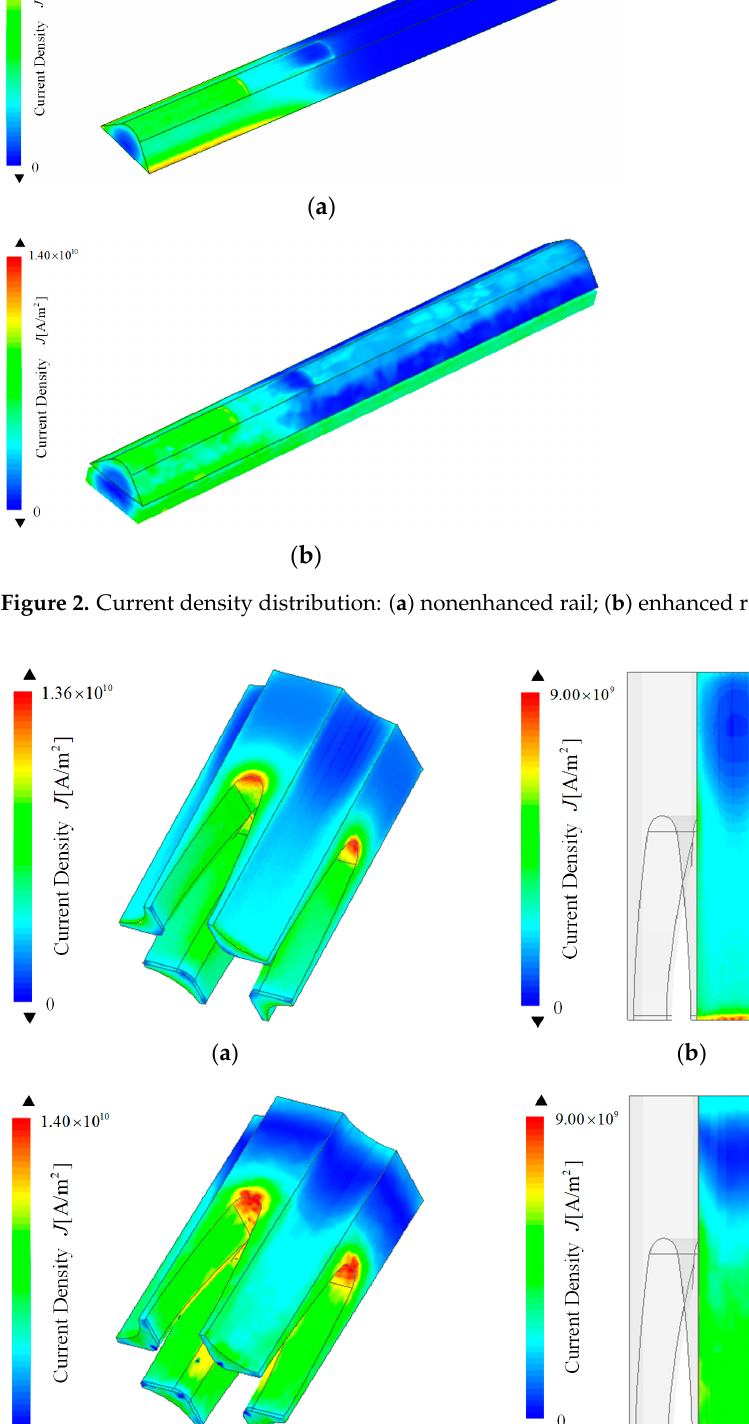
Figure 2. Current density distribution: ( a ) nonenhanced rail; ( b ) enhanced rail.